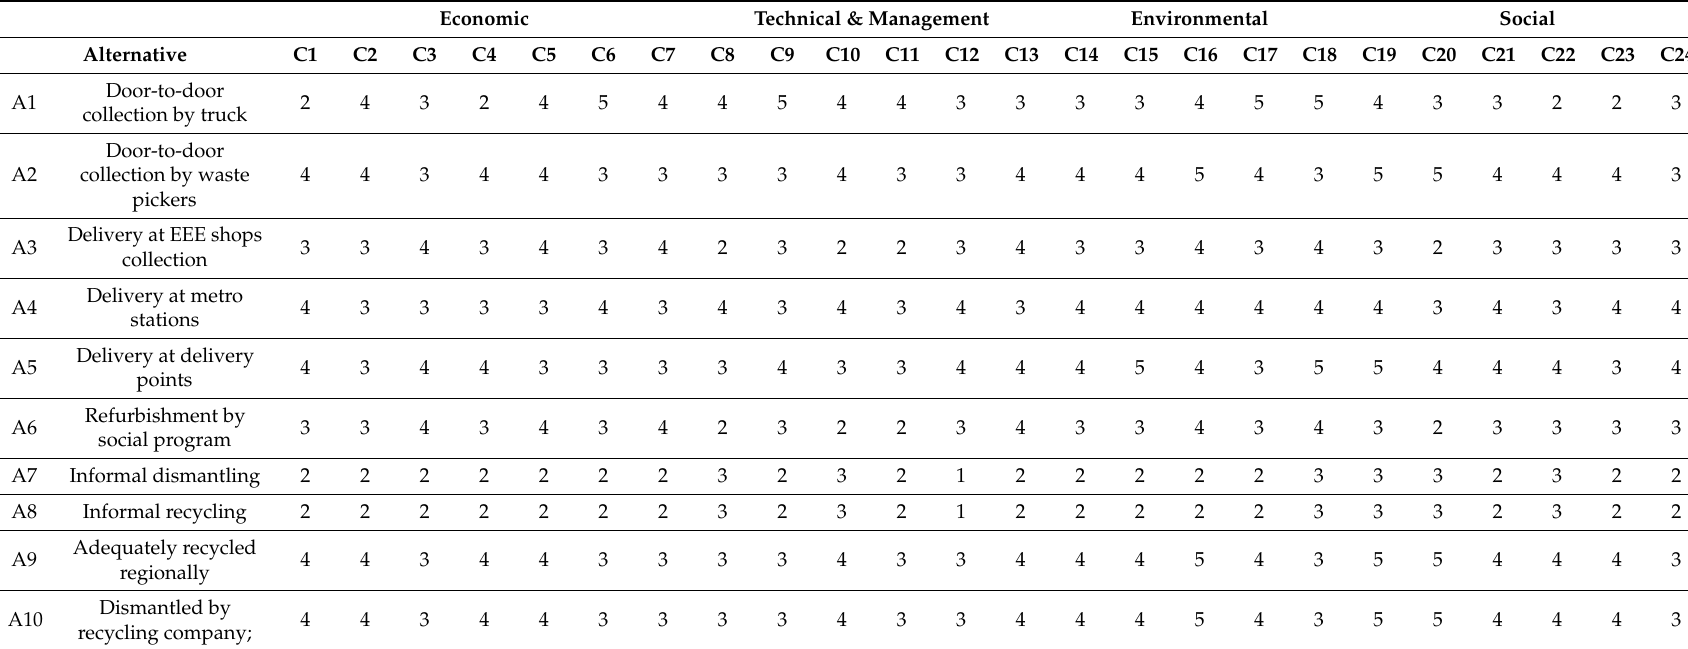
Table 10. Assessment of alternatives under the set of criteria from the numerical